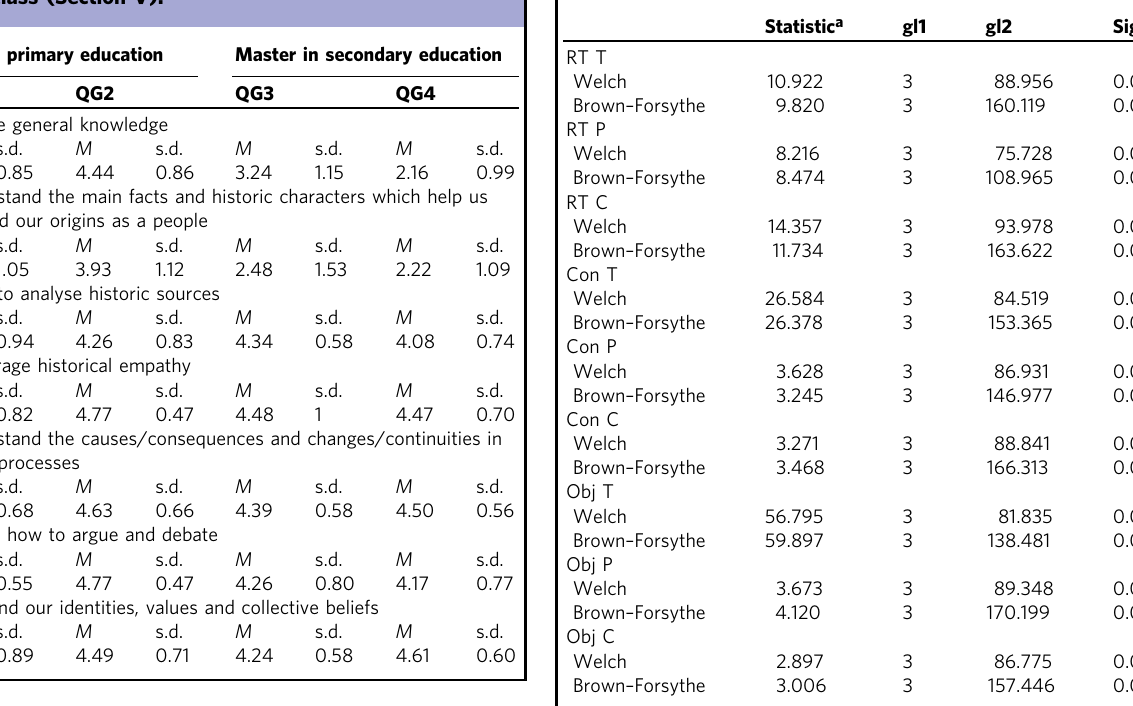
Table 7 Robust tests of equality of medians. Table 6 Descriptive statistics regarding the objectives of a